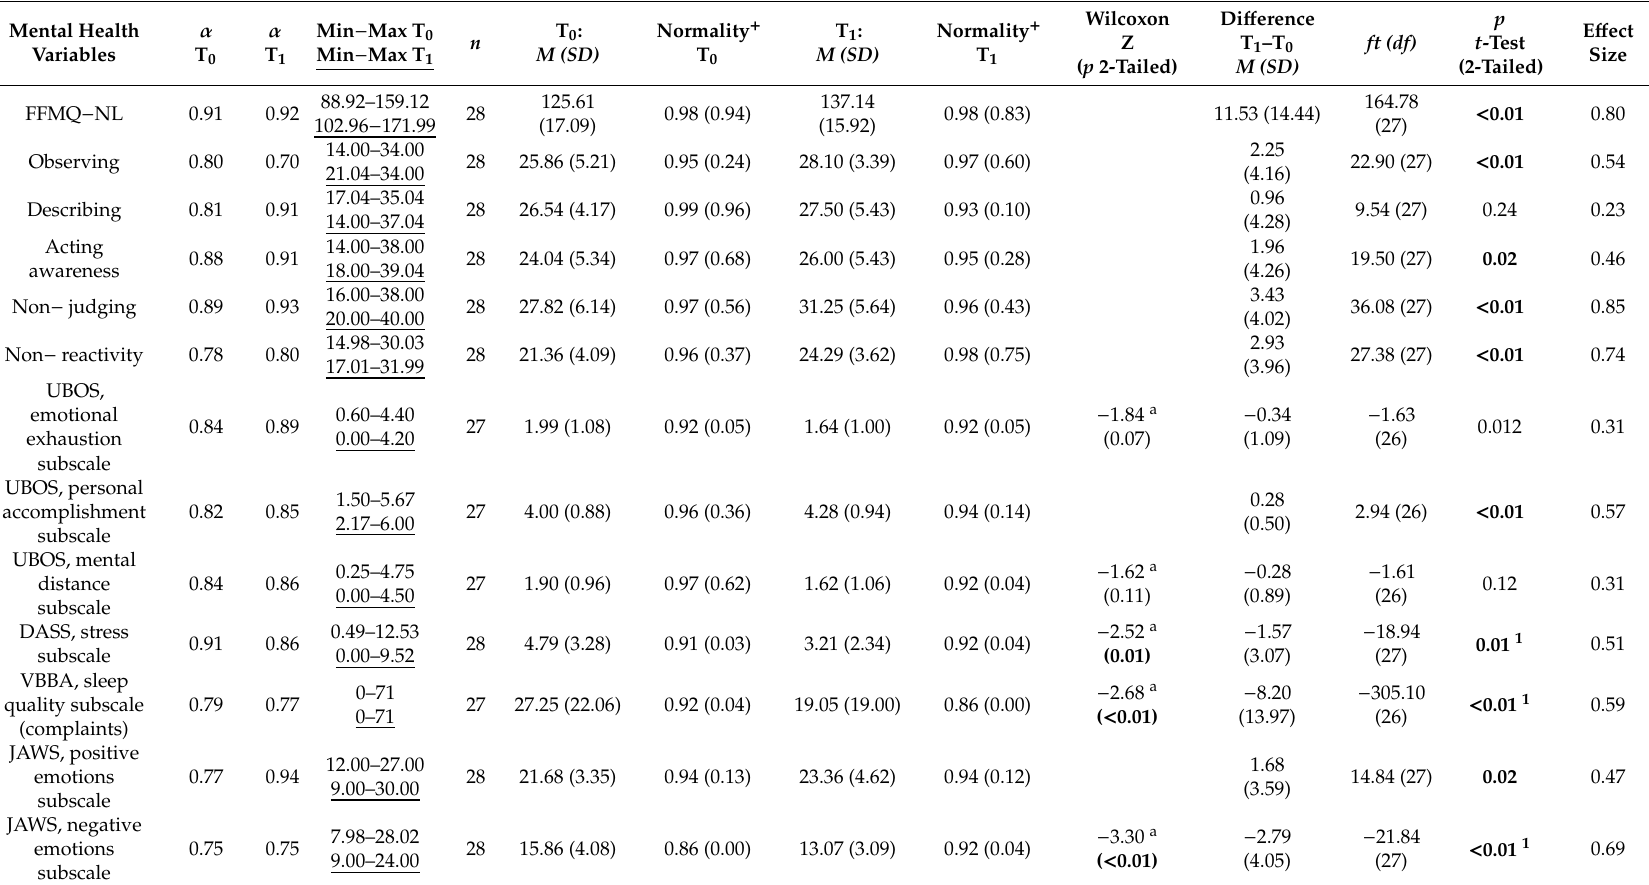
Table 1. Mental health variables’ ratings before and after the Mindfulness-Based Stress Reduction (MBSR)